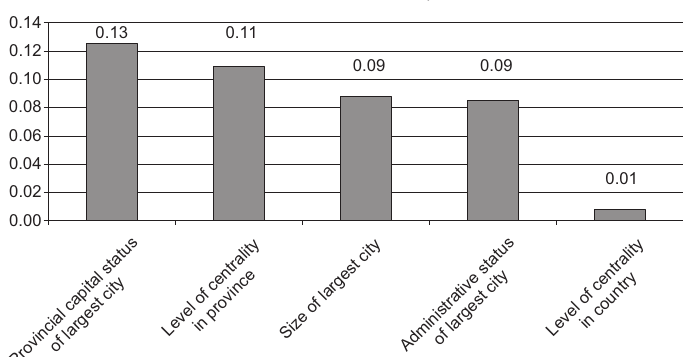
Fig. 5. Mean values of the Pearson correlation coefficients between independent variables and the absolute difference in development levels in the years 2005 and 2015* (DepVar 2). *2008 and 2016, respectively, in specified cases. Source: own elaboration.